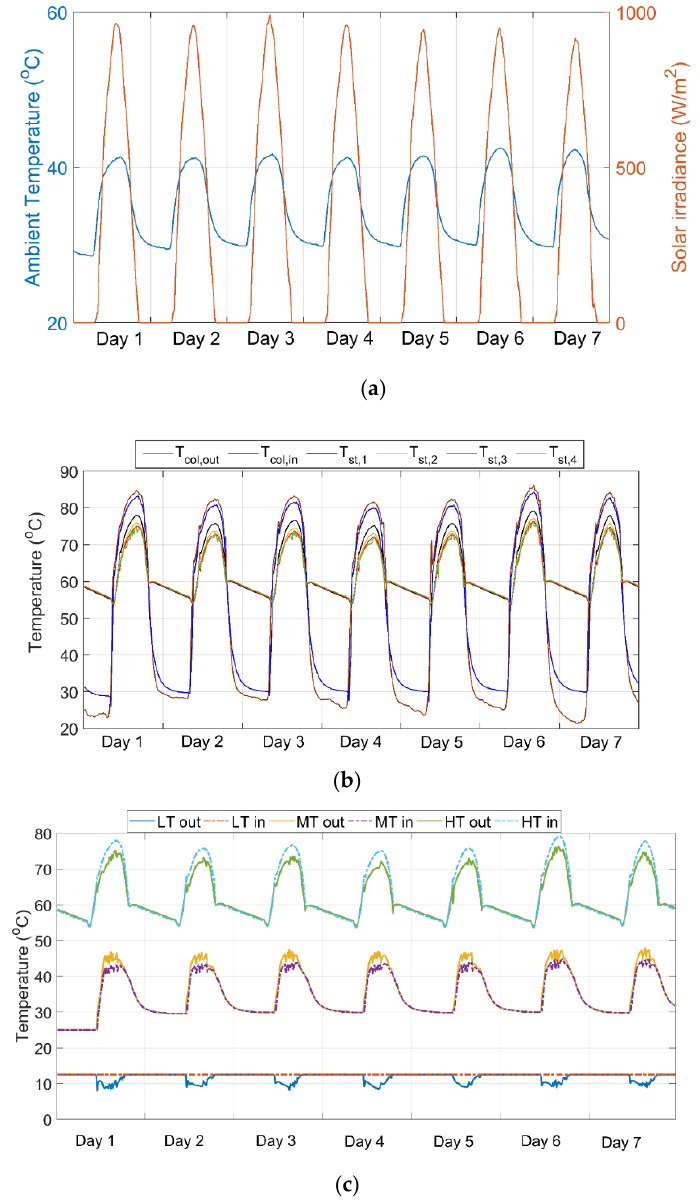
Figure 6. ( a ) Ambient conditions at the period of the experiments; ( b ) experimental results with respect to the solar sub-circuit temperatures and ( c ) with respect to the chiller’s secondary stream temperatures.